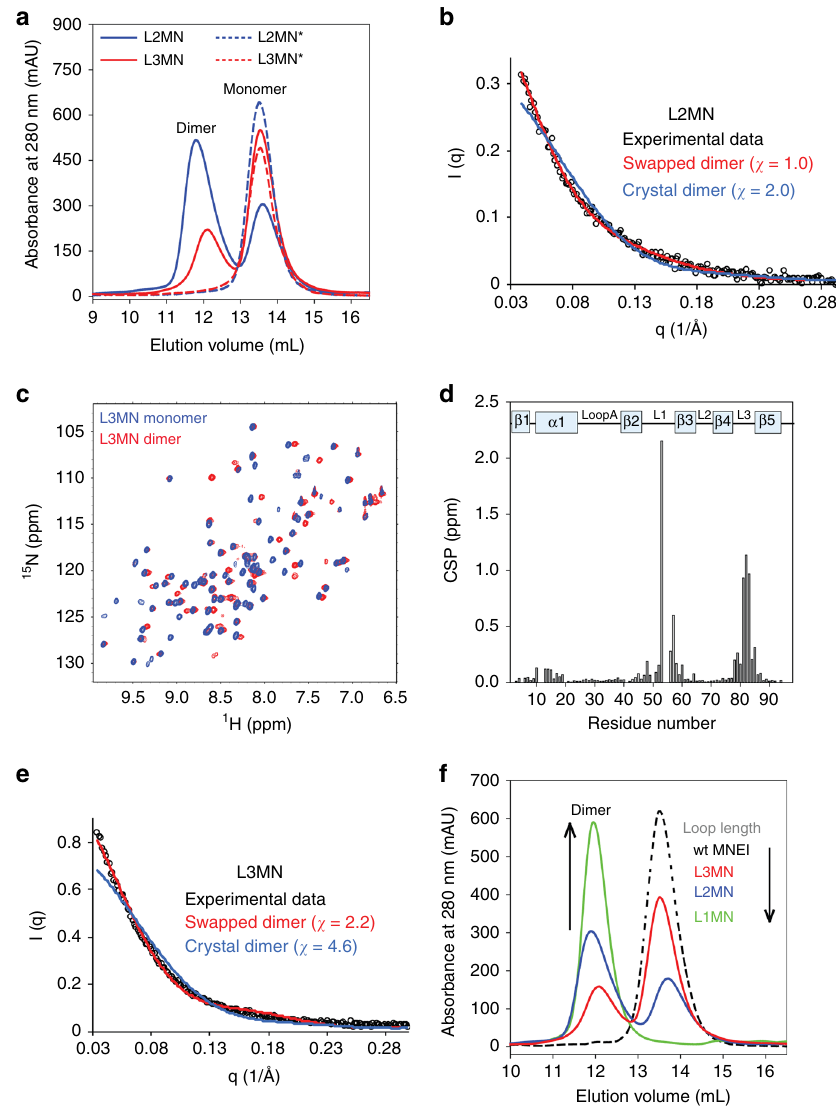
Fig. 3 Domain swapping in L2MN and L3MN. a Size exclusion pro fi les of L2MN, L2MN*, L3MN, and L3MN* at pH 7, are shown. L2MN* and L3MN* are variants of L2MN and L3MN respectively, in which the QVVAG sequence was mutated to QVNAG. Elution volumes corresponding to the dimeric and monomeric species are indicated. b The experimental SAXS data for the L2MN dimer is shown against the calculated scattering curves for the L2MN domain-swapped dimer based on a structural model derived from symmetrized-SBM simulations of L2MN, and for the wt MNEI crystal-contact dimer (PDB ID: 1IV7). c 15 N-HSQC spectra of L3MN monomer (blue) and dimer (red) align well for most resonances, indicating that their overall folds are similar. d Chemical shift perturbation (CSP) between the L3MN monomer and dimer is shown for each residue. A weighted chemical shift difference ( 1 H and 15 N) is plotted. For reference, the secondary structural arrangement of MNEI is indicated on the top. e The experimental SAXS data for the L3MN dimer is shown against calculated scattering curves for the L3MN domain-swapped dimer based on simulated models, and for the wt MNEI crystal-contact dimer (PDB ID: 1IV7). f Size exclusion pro fi les of wt MNEI, L1MN, L2MN, and L3MN are shown. Elution volumes corresponding to the monomeric and dimeric species are indicated. The fraction of the total protein that exists as a domain swapped dimer increases as the length of the target loop decreases (see Discussion). The total area under the elution peaks for each variant is comparable to the area under the elution peak for wt MNEI. Source data are